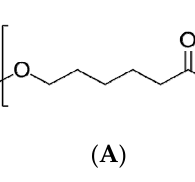
Figure 11. Chemical structure of ( A ) PCLa [117] and ( B ) PEO [118].